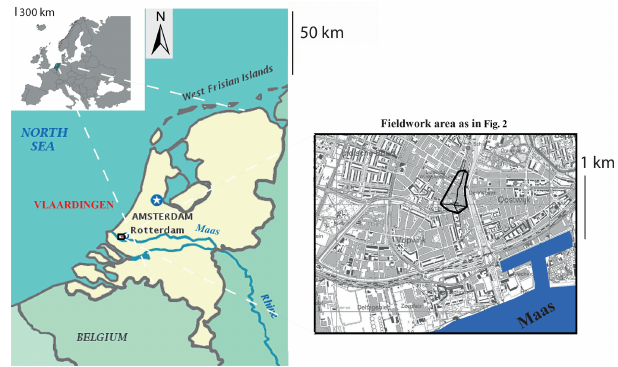
Figure 1. Map of Europe and the Netherlands showing locations of main cities and Vlaardingen, location of study